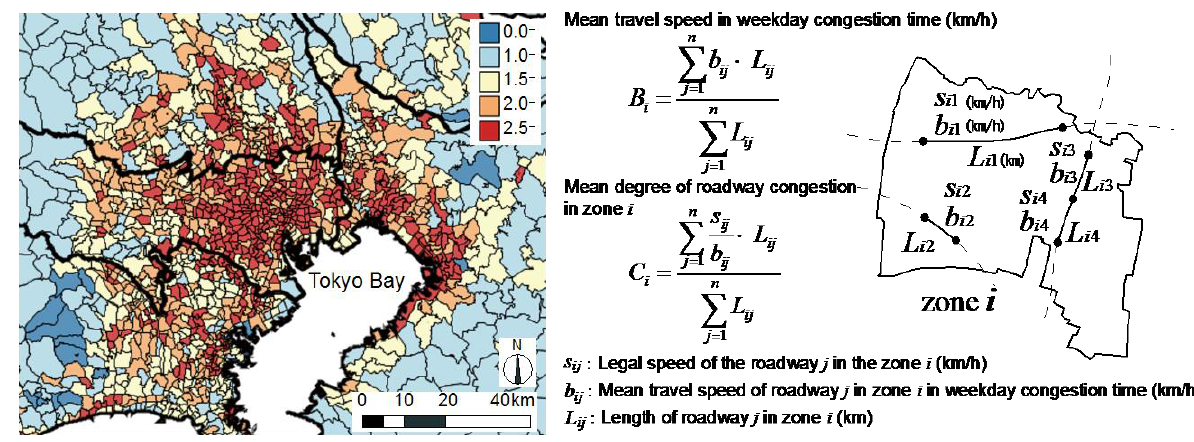
Figure 10. Method for assessing daily road congestion in the Kanto Region under usual